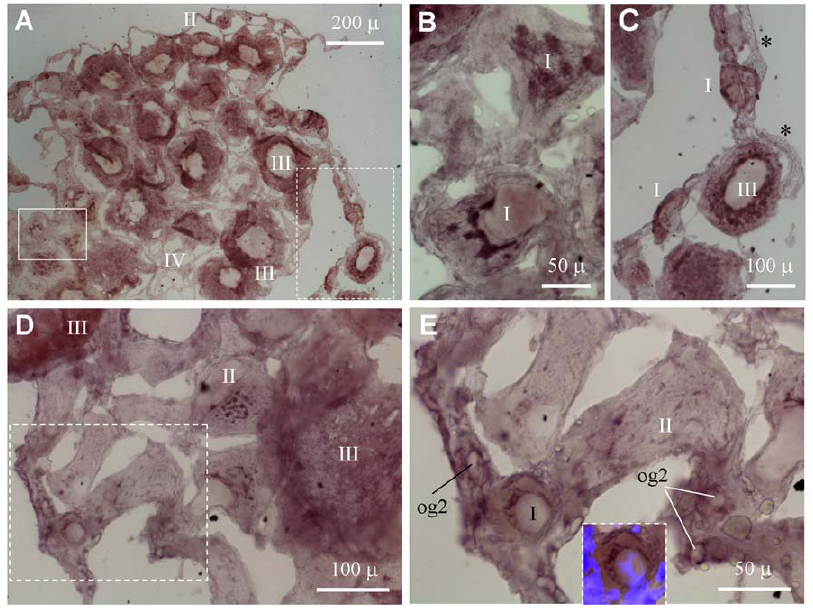
Figure 4. Expression of boule RNA during oogenesis. Adult ovarian cryosections were hybridized to antisense RNA probes and the signals were visualized by chromogenic staining. (A) Lower magnification view showing different stages of oocytes (I to IV). (B) Larger magnification of the area framed by solid line in (A), highlighting speckles of boule RNA in stage-II oocytes. (C) Larger magnification of the area framed by broken line in (A), highlighting the absence of boule RNA speckles in oocytes at stage I and III, and the lack of boule signal in somatic cells (asterisks). (D) Oogonia and early oocytes. (E) Larger magnification of the framed area in (D), highlighting differentiating oogonia (og2) and early oocytes at stage I with residual nuclear staining by DAPI (inset).